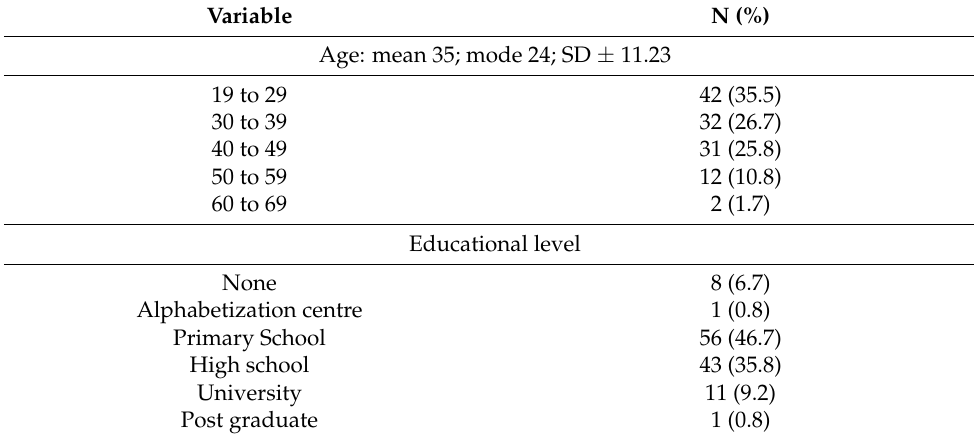
Table 1. Participants’ socio-demographic